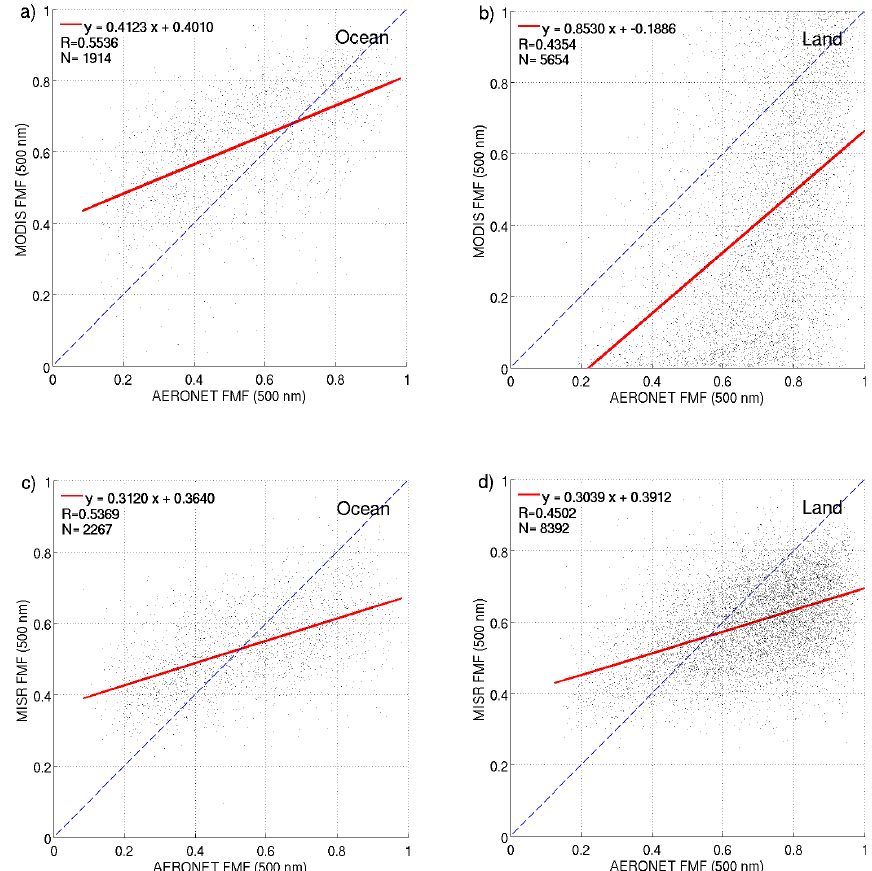
Fig. 5. Comparison of monthly AERONET FMF and monthly MODIS (or MISR) FMF. The data on the T42 resolution are used here. MISR FMF is defined as the ratio of fAOD to total